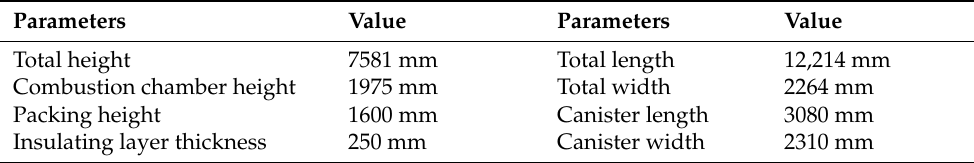
Table 2. Specifications of the